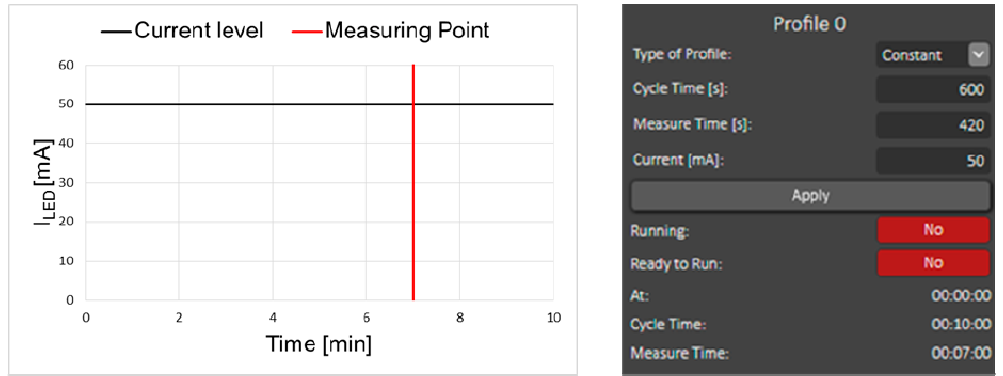
Figure 12. ( Left ): Current over time by a constant current profile. ( Right ): Configuration of a constant current profile in the LED Lifetime Analyzer software.